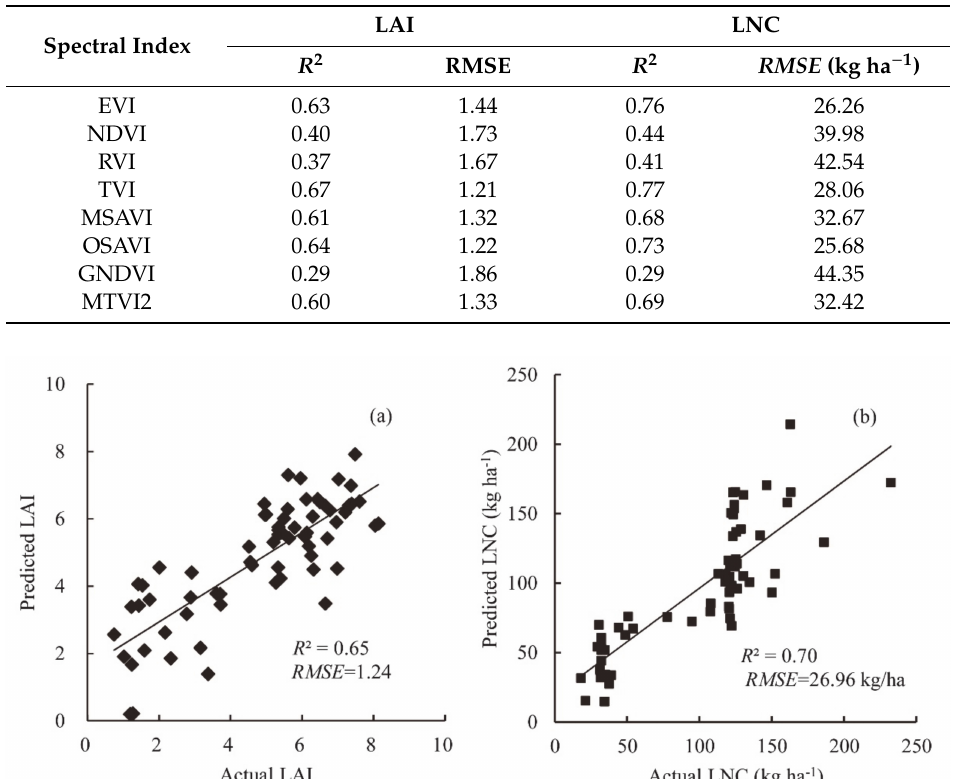
Table 4. Results of regression analysis between spectral indices and LAI and LNC values. Linear, logarithm, exponential, and powder models were used to conduct regression. The results of the optimal calibrated model are shown in the table. Regional sampling data for 2014 were used.